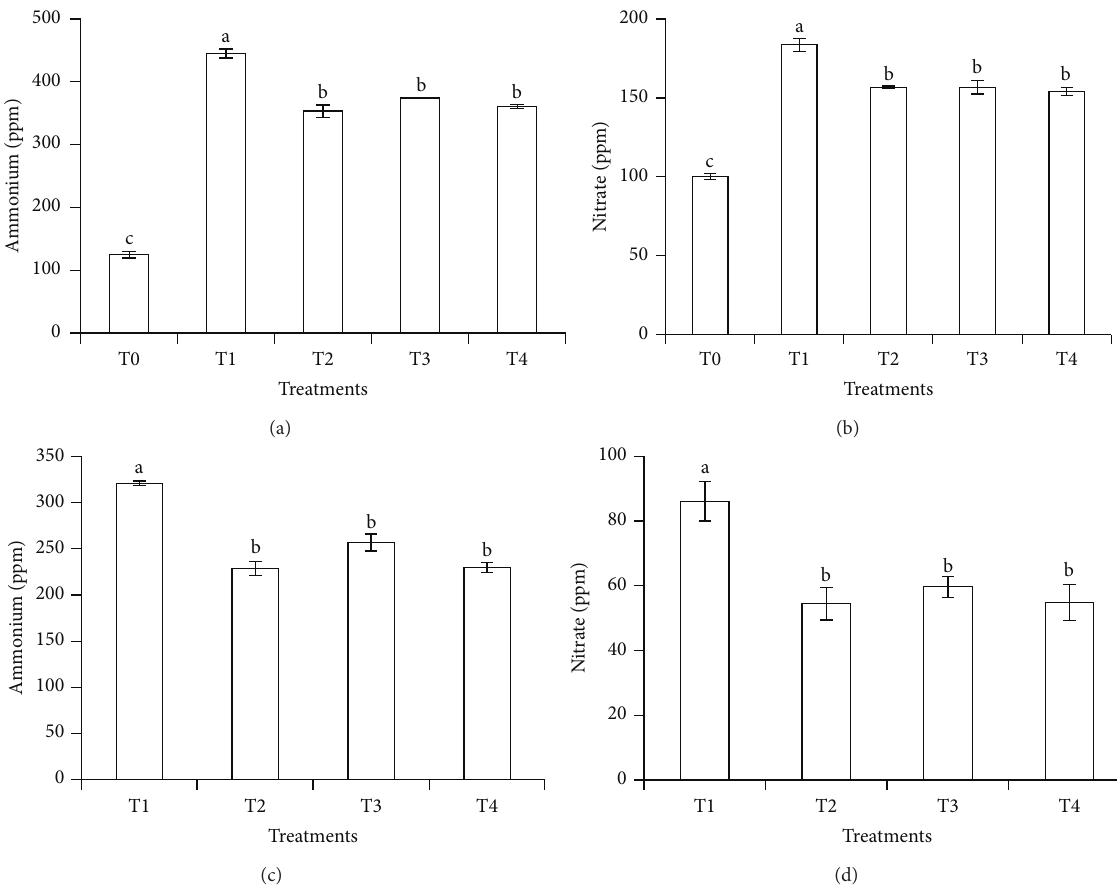
Figure 7: Cumulative amounts of ammonium and nitrate leached over 30 days of leaching experiment (a, b). Cumulative amounts of ammonium and nitrate leached (after subtracting the contribution of T0) over 30 days of leaching experiment (c, d). Note . T0: 64 g soil (no urea); T1: 64 g soil + 7.40 g urea (no additives); T2: 64 g soil + 7.40 g urea + 6g clinoptilolite zeolite; T3: 64 g soil + 7.40 g urea + 1.54 g compost; T4: 64g soil + 7.40g urea + 1.54 g compost + 6 g clinoptilolite zeolite. Means with different letters indicate significant difference between treatments by Tukey’s test at 𝑃 ≤ 0.05 . Note . Bar represents standard error of the mean.